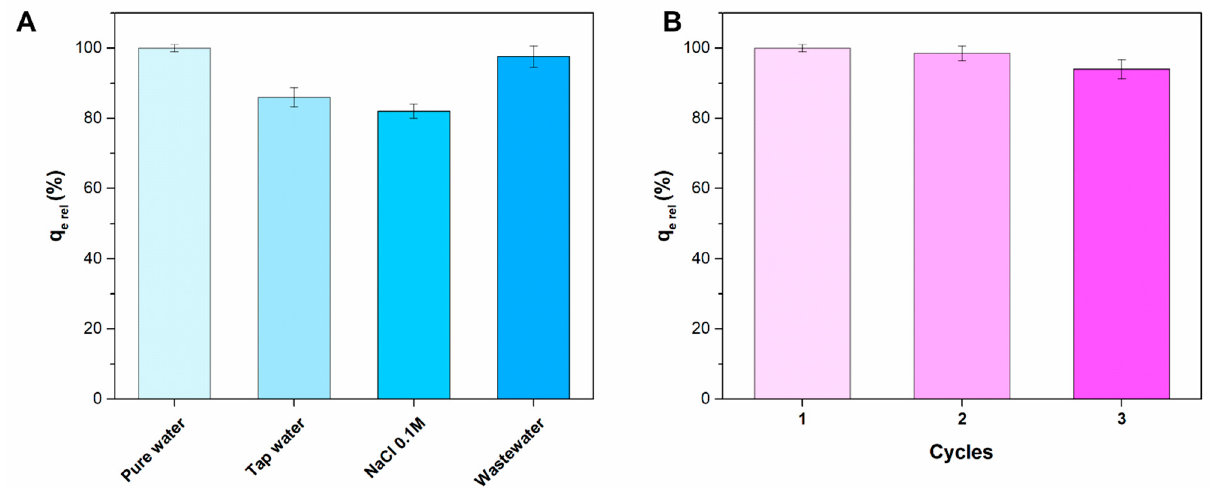
Figure 9. ( A ) Adsorption experiments in model effluent. ( B ) Adsorption performance and reusability of Liposome@PDA microspheres. Adsorbent mass 0.06 mg. MB concentration 4 mg/L. Temperature 298 K and equilibration time 90 min.